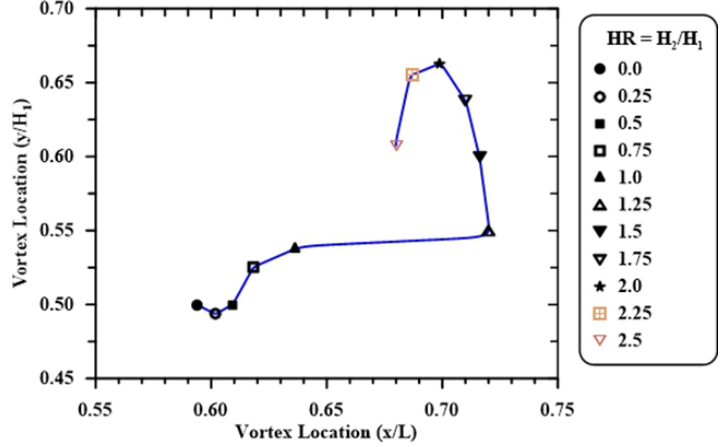
Figure 8. Locations of vortex center for the shallow cavity (AR = 5) at different height ratios (0.0 ≤ HR ≤ 2.5).